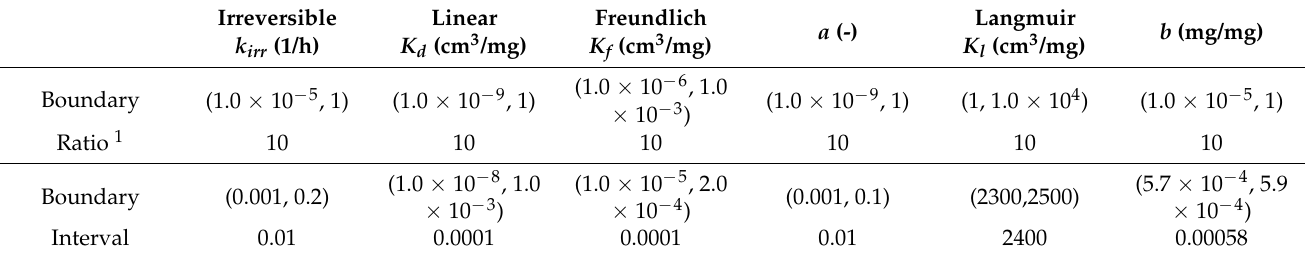
Table 2. Boundary values and intervals of parameters used for optimization algorithm.